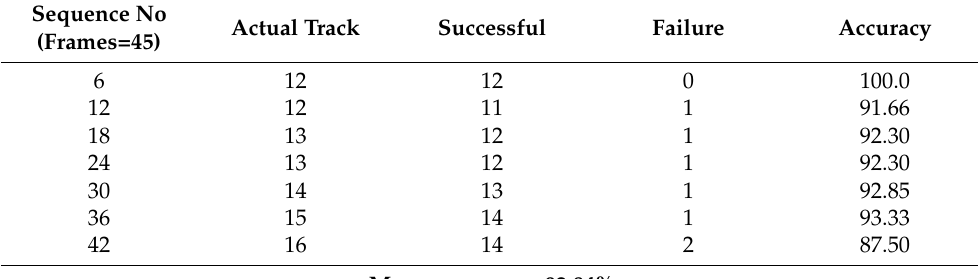
Table 3. Actual human detection and recognition accuracy over ADOC dataset.